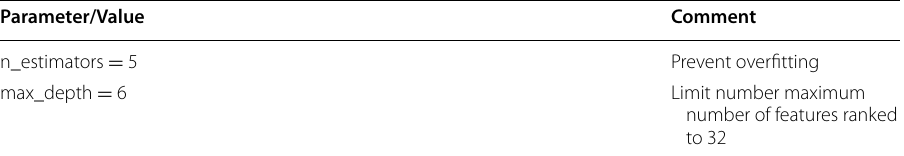
Table 3 Supervised ranking classifier Random Forest initialization options